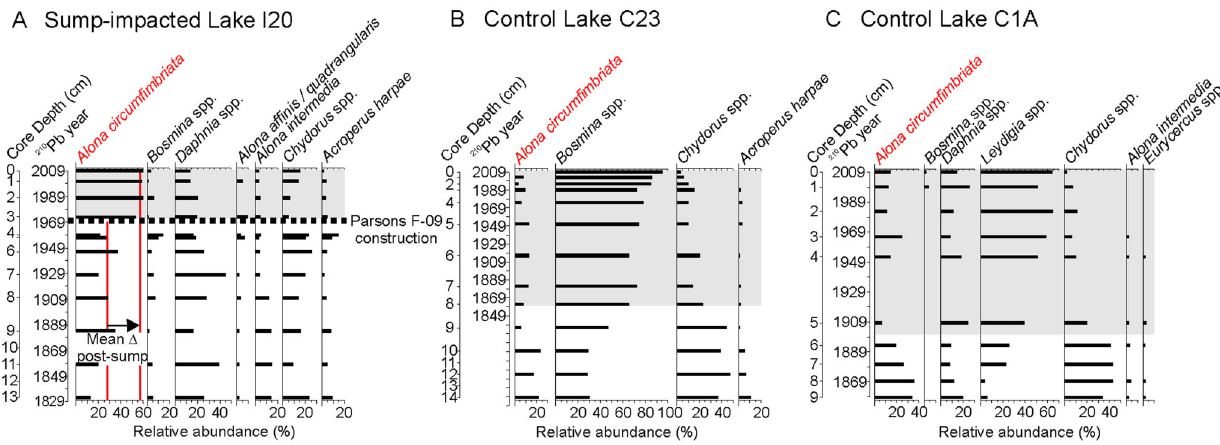
Figure 4. Stratigraphic profile of the most common cladoceran taxa from the three study lakes. Relative abundance diagrams from: lakes A) I20, impacted by drilling sump degradation; and control lakes B) C23; and C) C1A. Species assemblages (x axes) are scaled by relative abundance. Down-core sedimentary profiles (y axes) are scaled by date, based on 210 Pb radiometric dating techniques, with the depth in the sediment core included as a secondary axis. For all three lakes, two biostratigraphic zones were identified (constrained incremental sum of squares cluster analysis with the broken stick model) and are plotted with the background colour of one zone in grey the other white. The known timing of construction of the compromised drilling sump near Lake I20 (industry ID: Parsons F-09) is included as a horizontal line. The vertical red lines represent the pre- and post-sump construction mean of the relative abundance of the cladoceran Alona circumfimbriata .